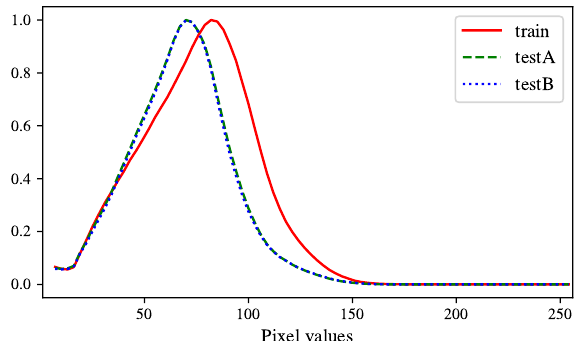
Figure 3. Histograms of the dataset divided into three parts (best viewed in color). For convenient comparison and presentation, we scaled the distribution of each set to the range [0, 1] and drew its histogram as a line. Note that the zero values were excluded as they dominate the data